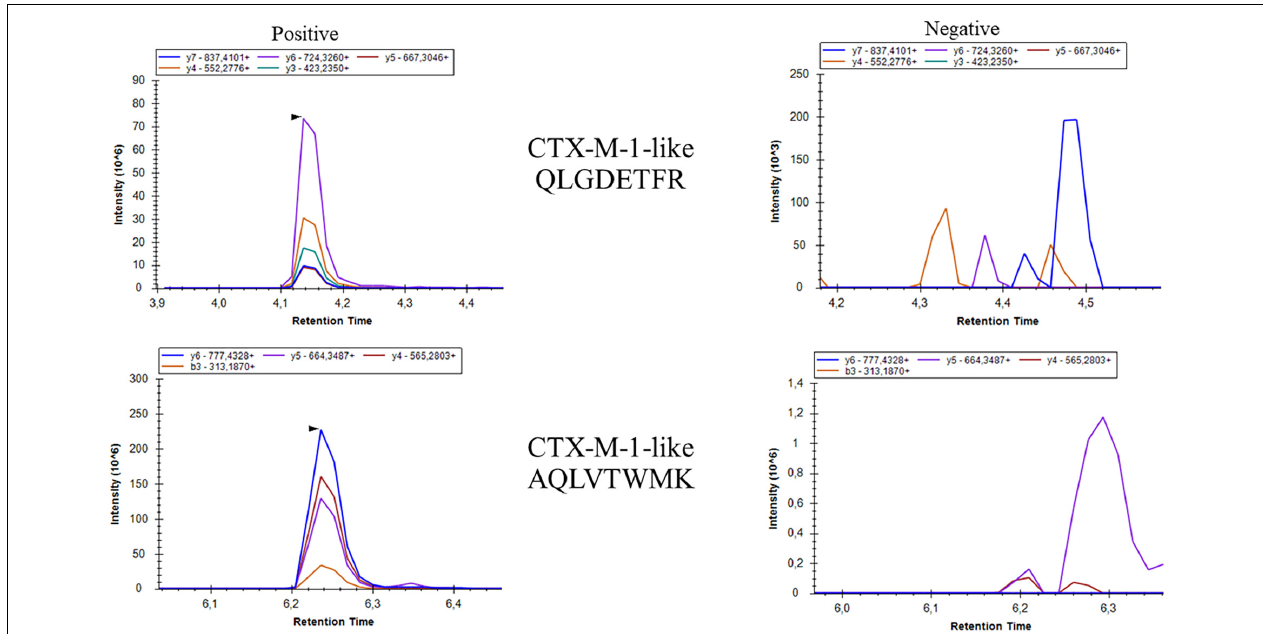
FIGURE 2 | Examples of positive and negative LC-MS/MS spectra of peptides selected for TEM and CTX-M. On the x -axis, the retention time in minutes, on the y -axis the signal intensity in unadjusted units rescaled to show clear spectra, or a lack thereof in the negative